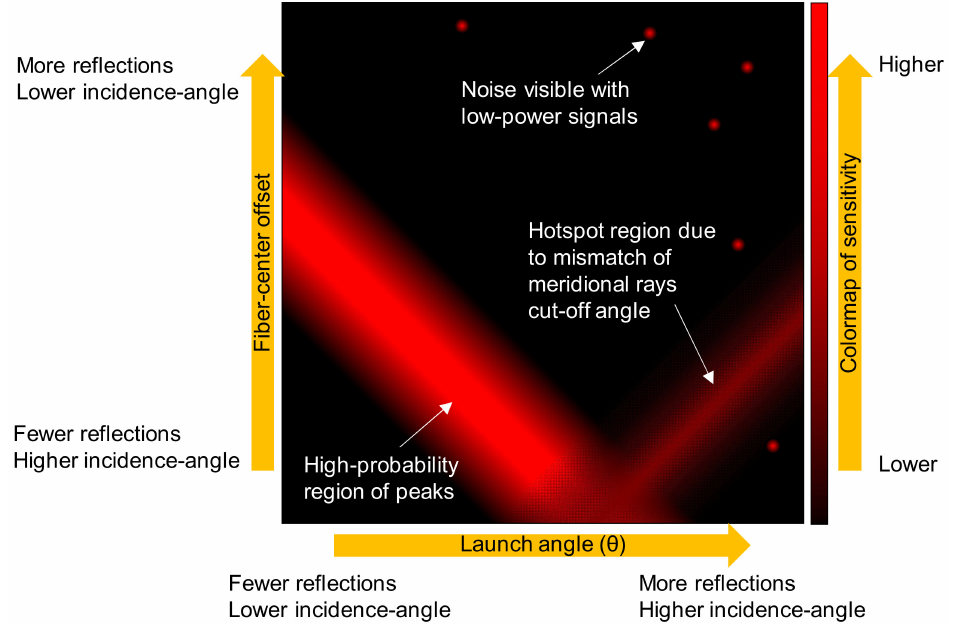
Figure 7. Illustration of the contribution to θ φ from the fiber-center o ff set and the input light